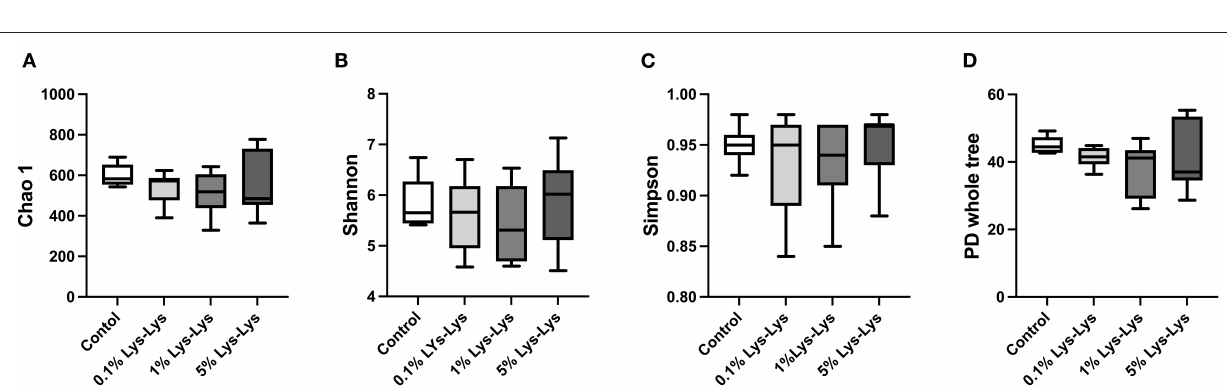
FIGURE 4 | Effect of the Lys-Lys dipeptide on intestinal microbiota in piglets. Data were expressed as the mean ± SEM ( n = 7). *Different from control, P < 0.05. (A) Chao1. (B) Shannon. (C) Simpson. (D) PD whole